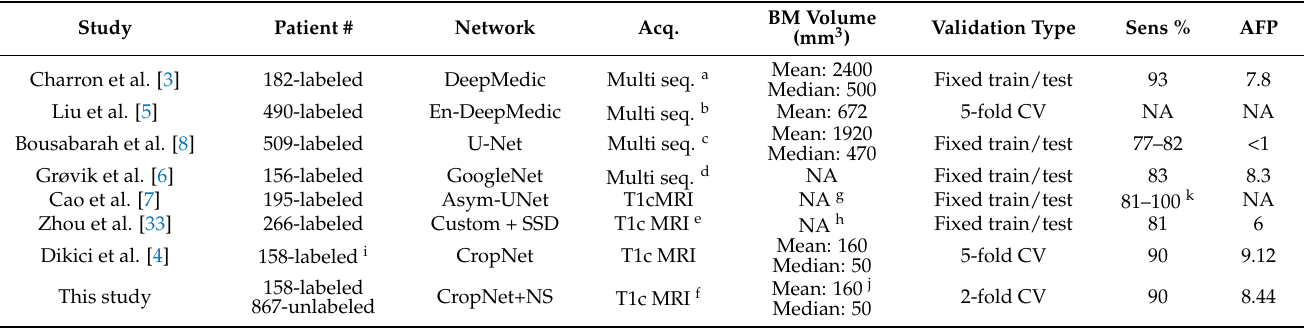
Table 6. Overview of selected group of SOTA BM segmentation/detection